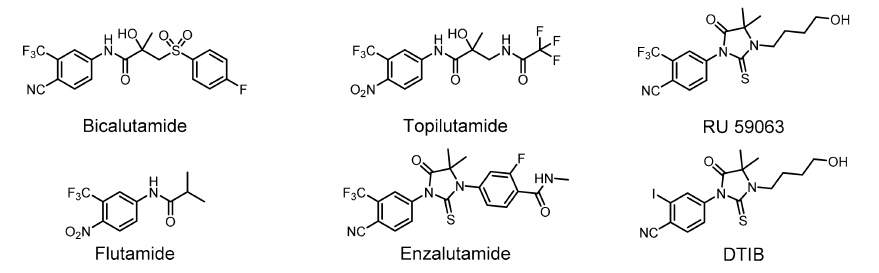
Figure 1. Structures of representative androgen receptor (AR) modulators.